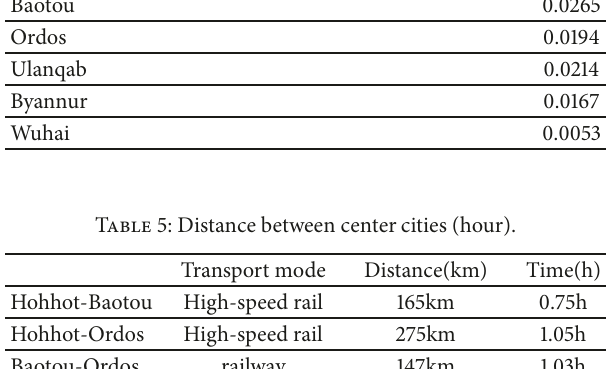
Table 4: Population of each city in 2015(billion people). Hohhot